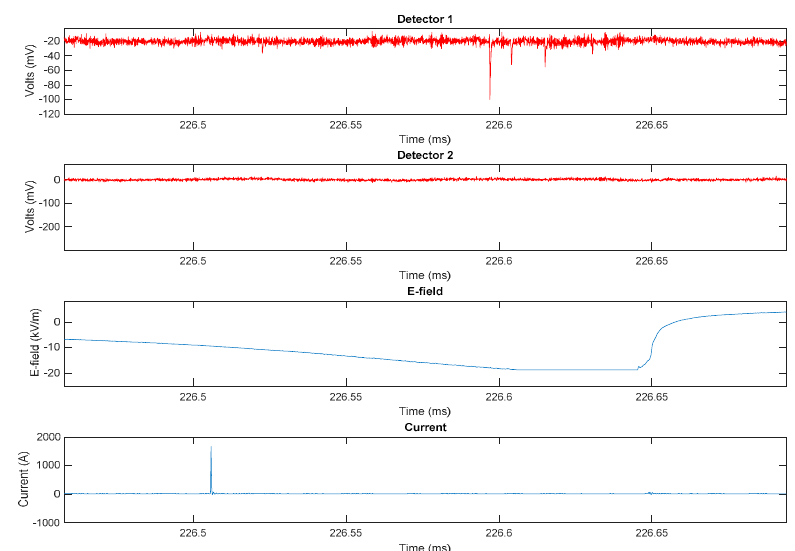
Figure 4. X-ray burst associated with the fourth (third subsequent) return stroke. The time t = 0 corresponds to 16:09:36.072213 UTC. X-rays are only detected in the un-attenuated detector. According to ALDIS, this 22-kA stroke occurred at a distance of 500 m from the tower. Peak energy of the burst is about 650 keV. The timestamp of the RS is 16:09:36.665124 UTC.